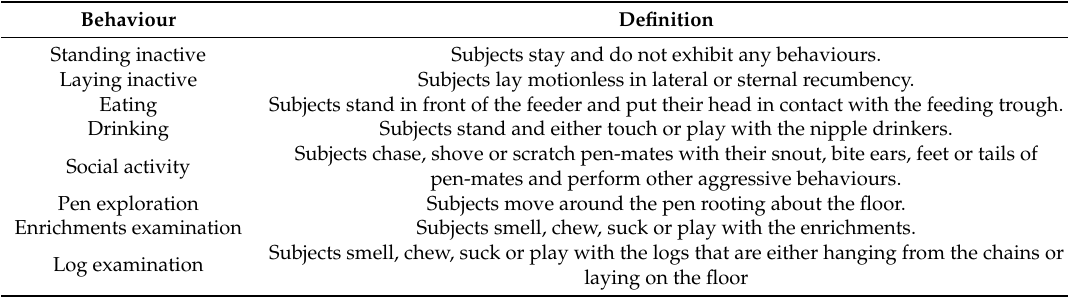
Table 1. Definition of the analysed behaviours.